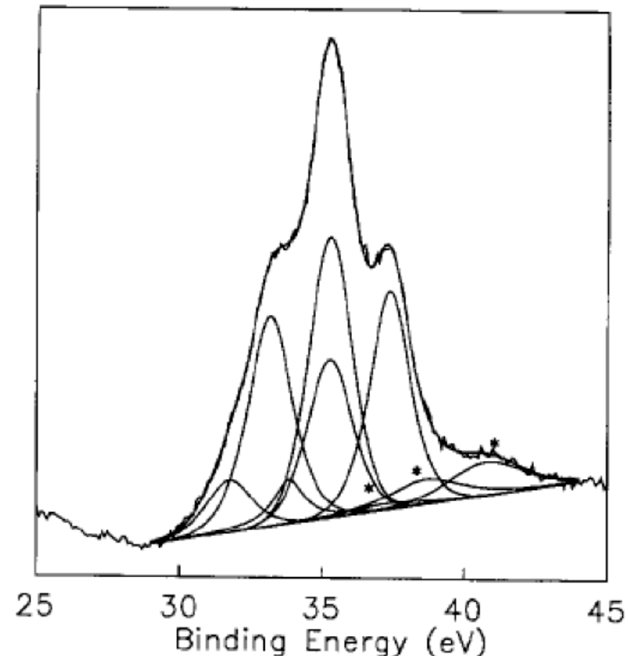
Figure 4. Fitting of the W4f energy region. The stars indicated the 5p 3/2 which had to be added to the 4f 7/2 + 4f 5/2 doublets for a correct fit of the experimental curve. Reprinted from Figure 6a in Surf.